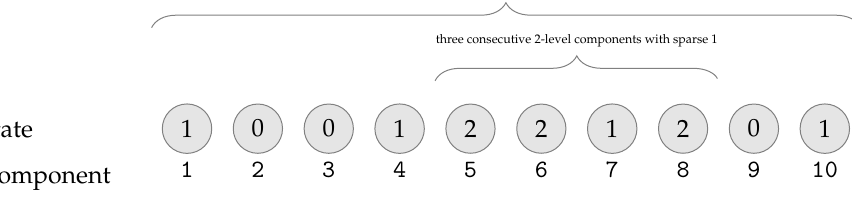
Figure 1. Lighting system: bulb linear arrangement in Example